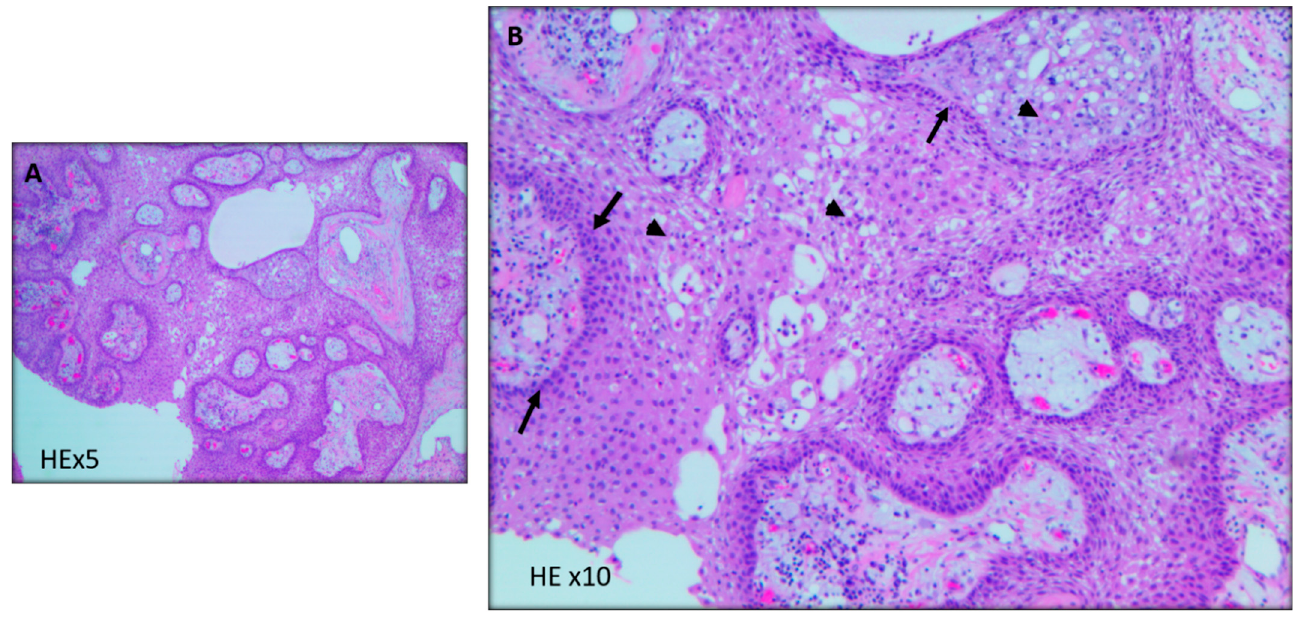
Figure 2. Craniopharyngioma with mixed papillary and adamantinomatous patterns with well differentiated squamous epithelium around fibrovascular cores. ( A ) Focal arears in the tumor show adamantinomatous pattern of craniopharyngioma displaying nodular and trabecular cellular growth with peripheral nuclear palisading (( B ), arrow head) and looser plumper stellate reticulum cells (( B ), arrows). HE = hematoxylin and eosin.